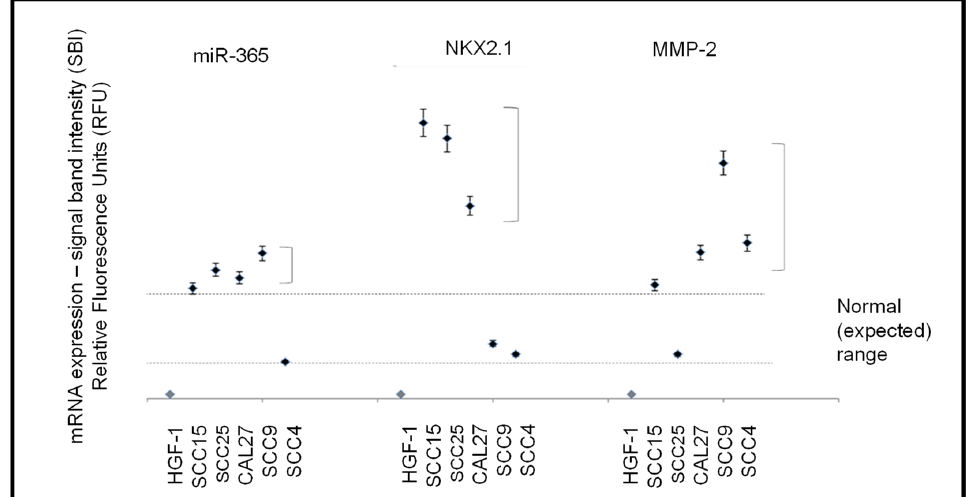
Figure 4. Expression of mRNA and microRNA. The normal, non-cancerous cell line HGF-1 did not express miR-365, NKX2.1, or MMP-2 with variable expression among the oral squamous cell carcinoma lines. Higher than expected levels of miR-365 were detected in all SCC lines except SCC4, p = 0.044. Higher than expected mRNA expression levels of NKX2.1 were observed in all SCC lines except SCC4 and SCC9, p = 0.038. MMP-2 was expressed in high levels among all SCC cell lines, except SCC25, p = 0.041.